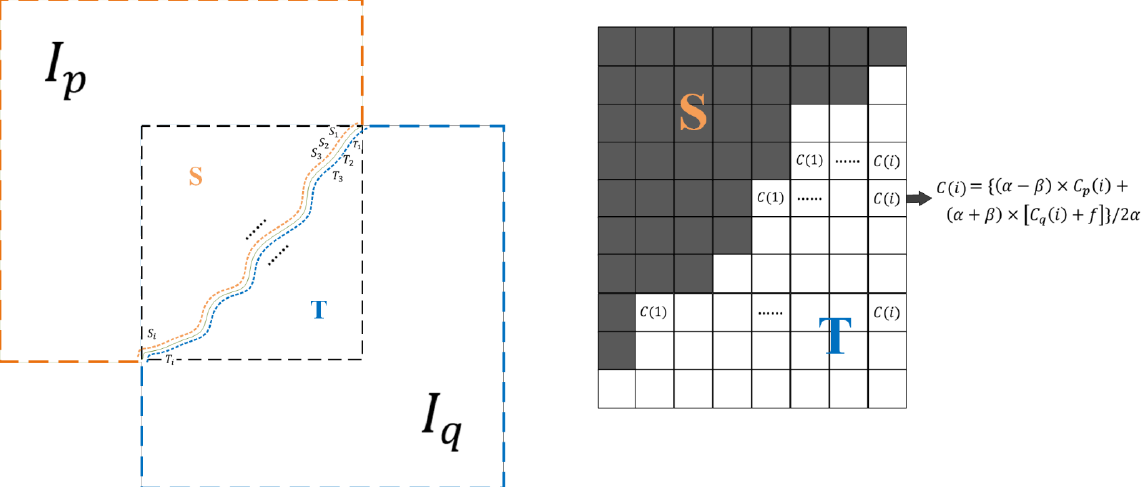
Figure 6. Adjustment of the original image leveling process and the reference image pixel point value during the leveling process.